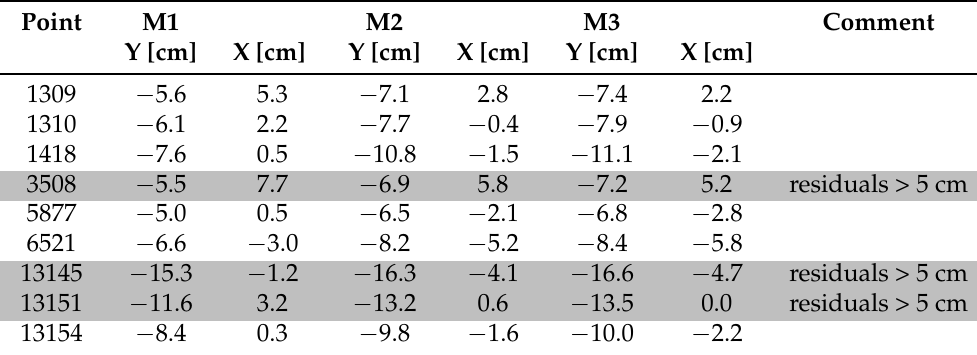
Table 2. Results of the different methods: M1 (local transformation by 2D Helmert transformation), M2 (IDW based on residuals), and M3 (IDW based on homogeneous